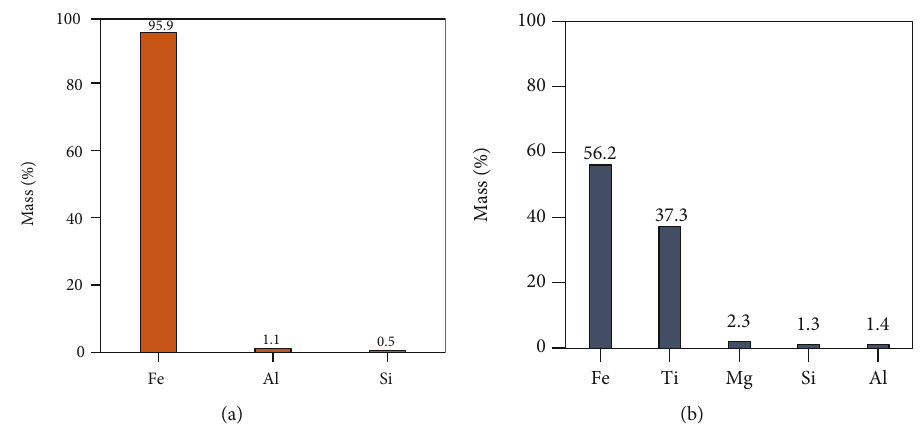
Figure 4: The elemental composition is derived from an XRF measurement on (a) hematite and (b) ilmenite.